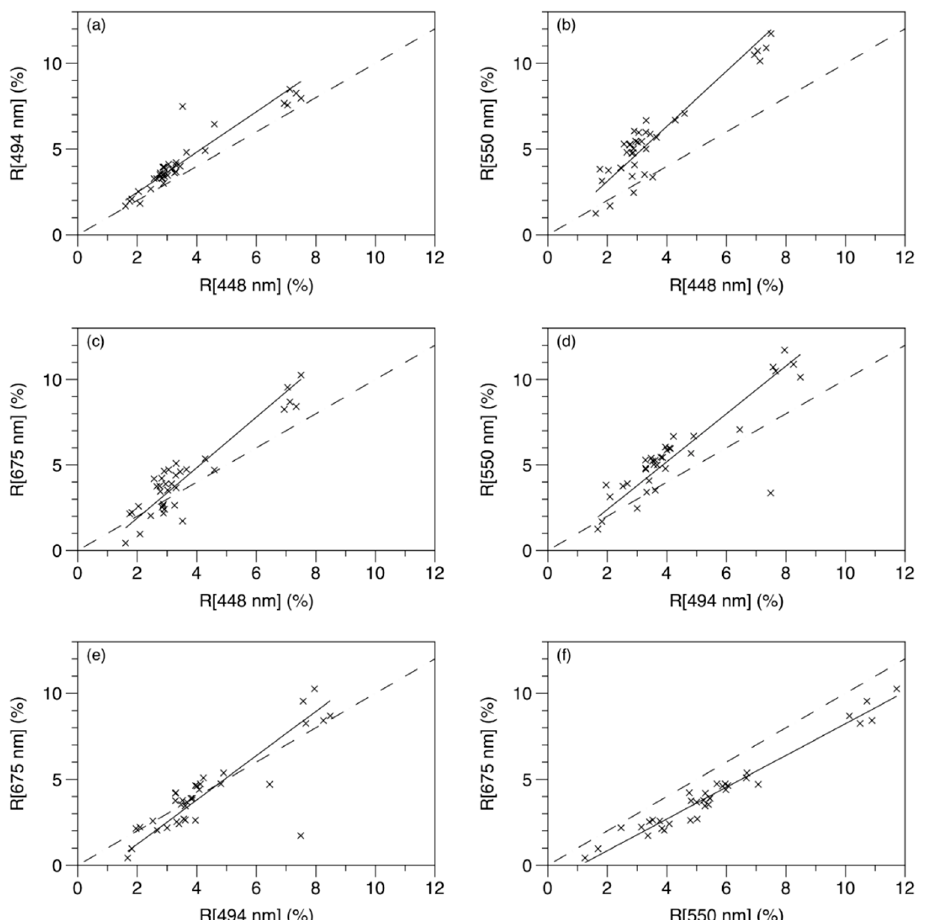
Figure 3. Orthogonal linear regressions between reflectance measurements performed at different wavelength band combinations using 448 nm, 494 nm, 550 nm and 675 nm respectively, (a-f). The regression line is represented by the solid lines and the line y = x (first bisector) is represented by the dashed lines. Parameters (slope and intersect), along with the respective determination coefficients (R²) are provided for all graphs (a to f) in Table 2.